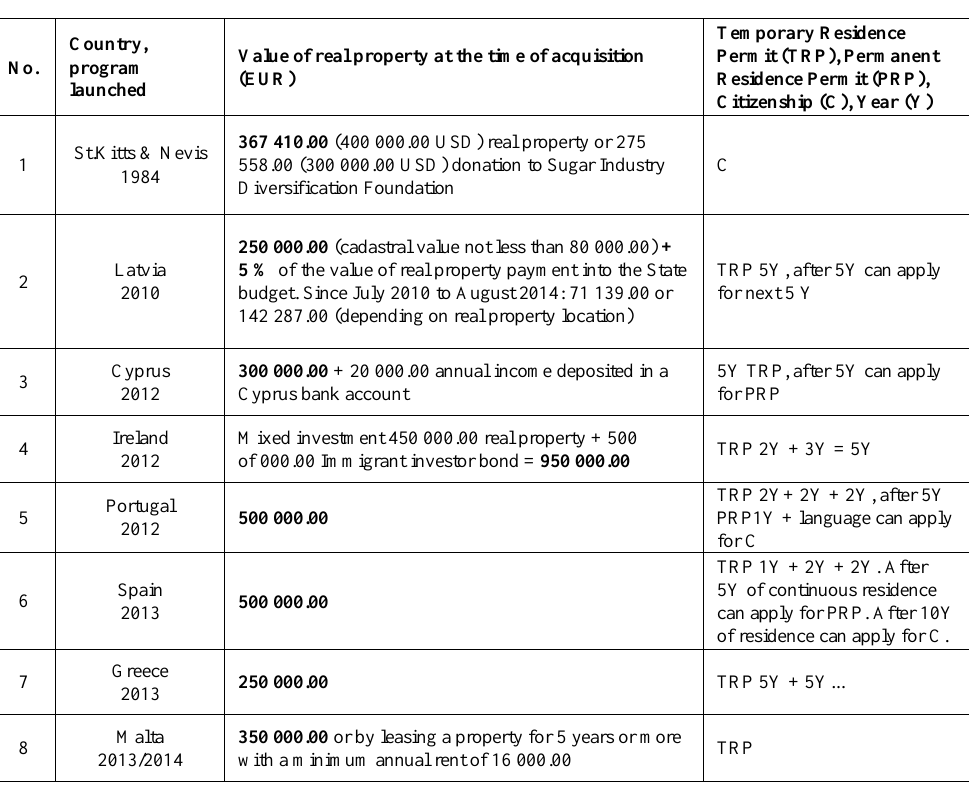
Table 1 . Conditions for temporary residence permits by purchasing real property in selected